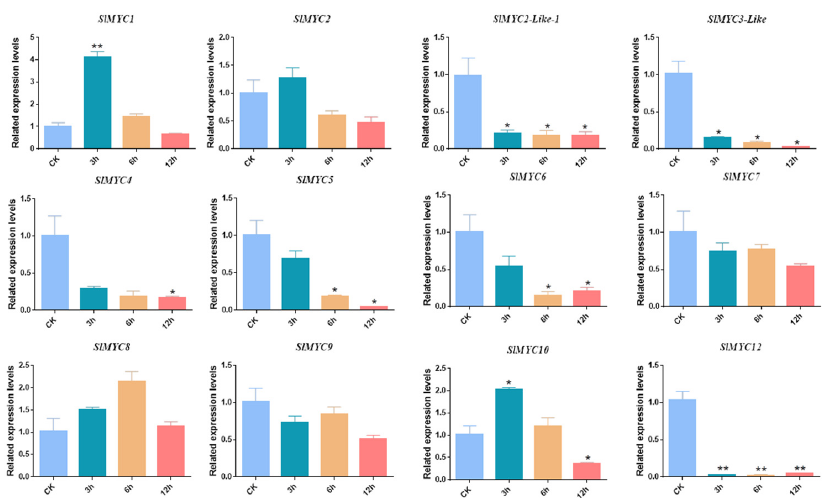
Figure 7. Response analysis of SlMYC genes in tomato leaves under NaCl stress by qRT-PCR. The expression patterns of SlMYC in response to 150 mM NaCl treatment for 3 h, 6 h, and 12 h. Data represent the means of three biological replicates ± SD. Different colors were used to indicate different treatment times ( p -values less than 0.05 are summarized with one asterisk, and p -values less than 0.01 are summarized with two asterisks).